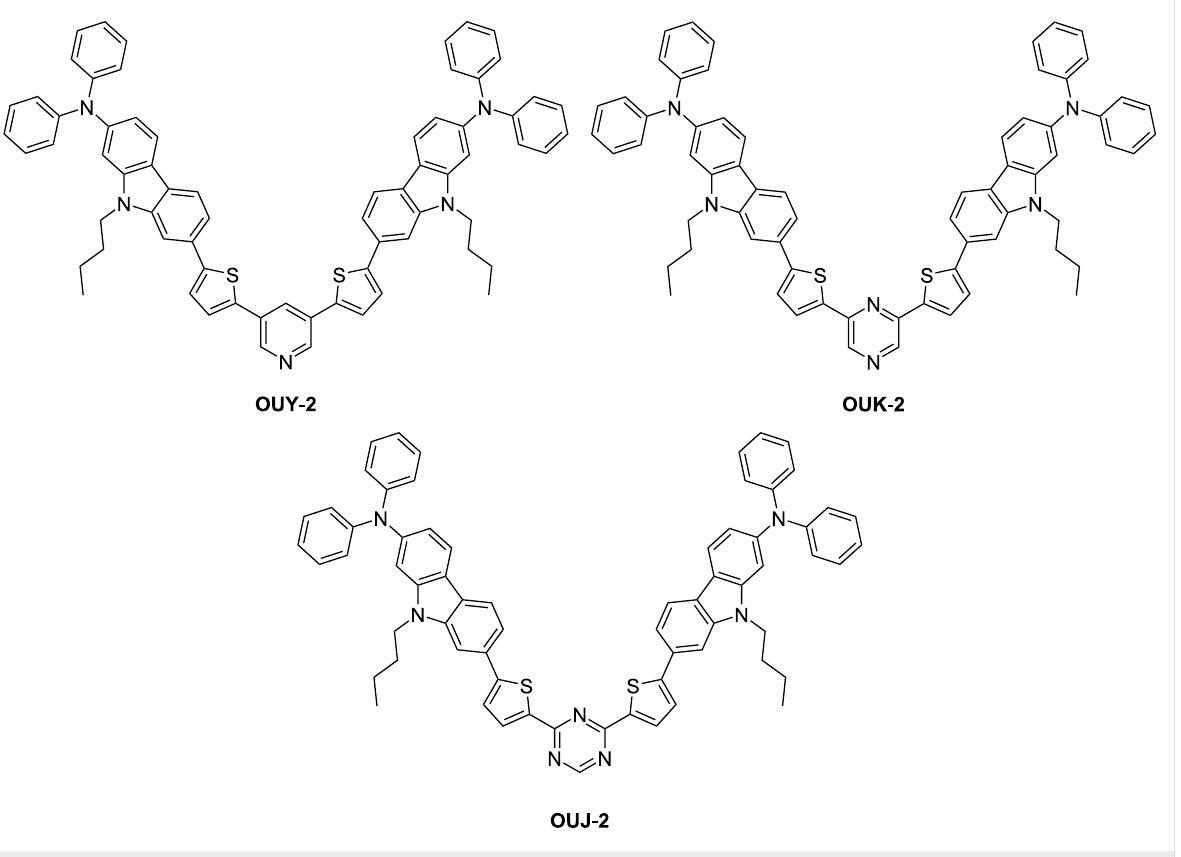
Figure 1: Chemical structures of the (D– π –) 2 A fluorescent dyes OUY-2 , OUK-2 and OUJ-2